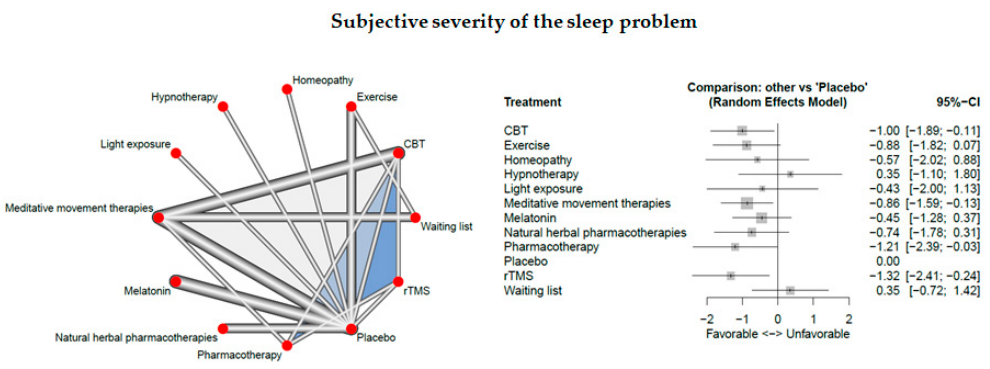
Figure 5. Subjective severity of the sleep problem .